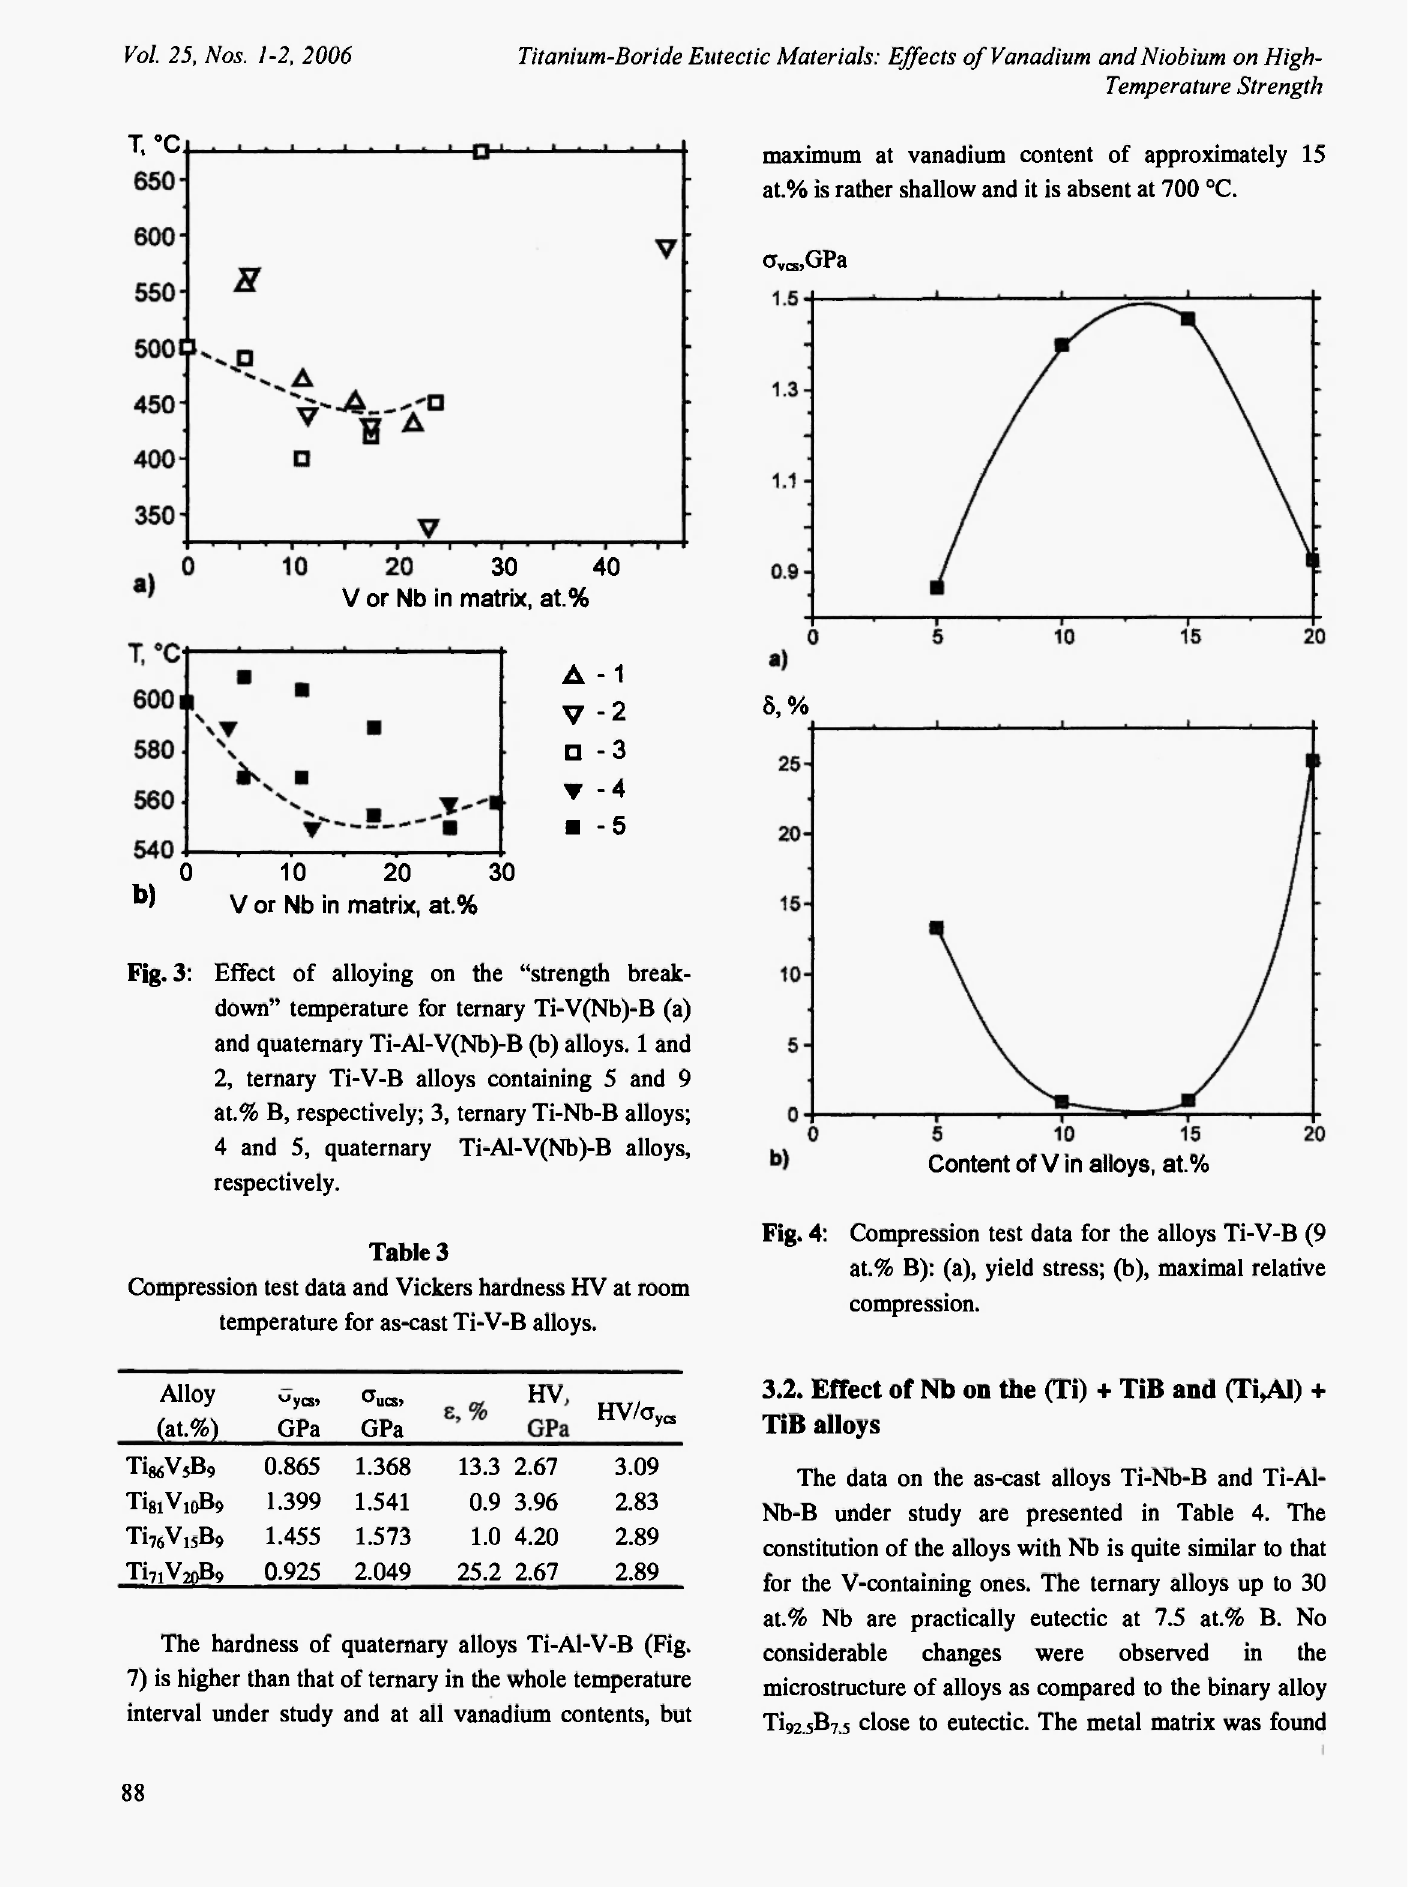
Fig. 3: Effect of alloying on the "strength break- down" temperature for ternary Ti-V(Nb)-B (a) and quaternary Ti-Al-V(Nb)-B (b) alloys. 1 and 2, ternary Ti-V-B alloys containing 5 and 9 at.% B, respectively; 3, ternary Ti-Nb-B alloys; 4 and 5, quaternary Ti-Al-V(Nb)-B alloys, respectively. Compression test data and Vickers hardness HV at room temperature for as-cast Ti-V-B alloys.